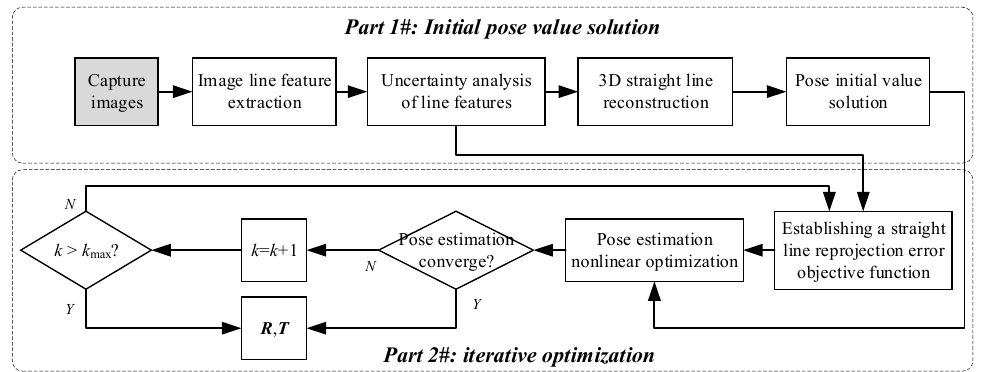
Figure 6. Flow chart of the outer space non-cooperative target pose estimation algorithm.